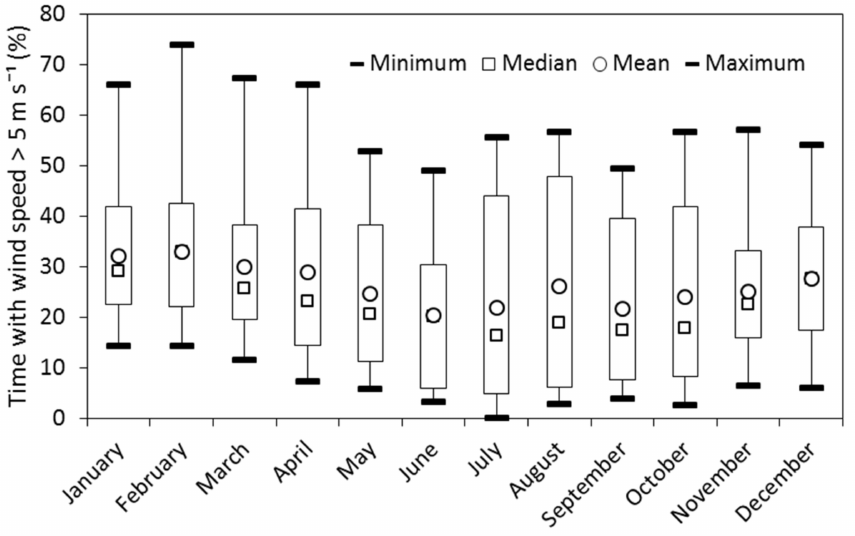
Figure 11. Percentage of time with wind speed above 5 m · s –1 in the Sierra Nevada mountain